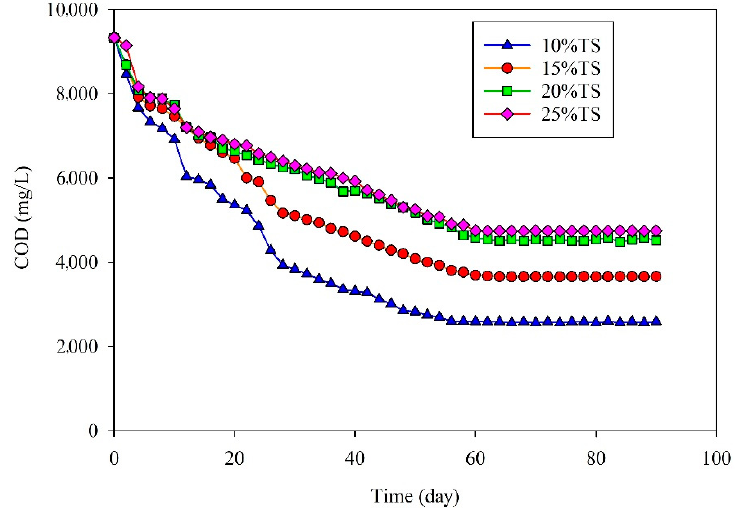
Figure 3. Effect of different percentages of total solids (TS) on nondelignified C/N 25 (g/g) biogas chemical oxygen demand (COD).